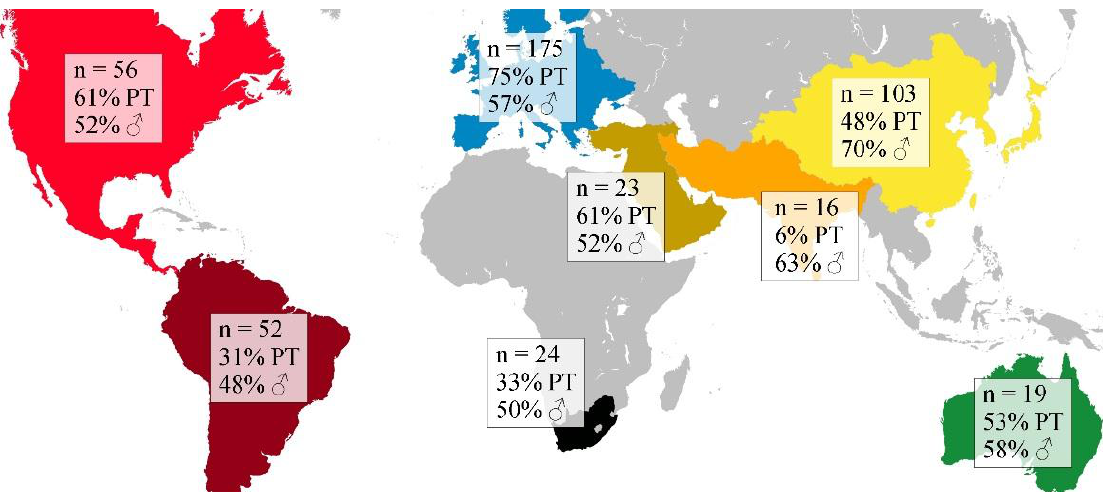
Figure 1. Regions of origin of participants (absolute numbers per region), including percentage (%) of individuals born preterm (PT) and percentage (%) of males ( ♂ ). For Asia, we provide information on three of the five geographical subregions: Western Asia (sand color), South Asia (orange), and East Asia (yellow).